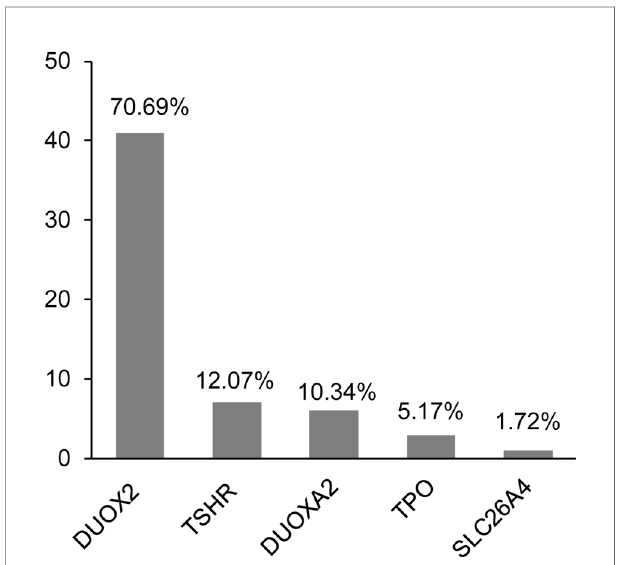
FIGURE 1 | Distribution of the 58 detected variants in fi ve